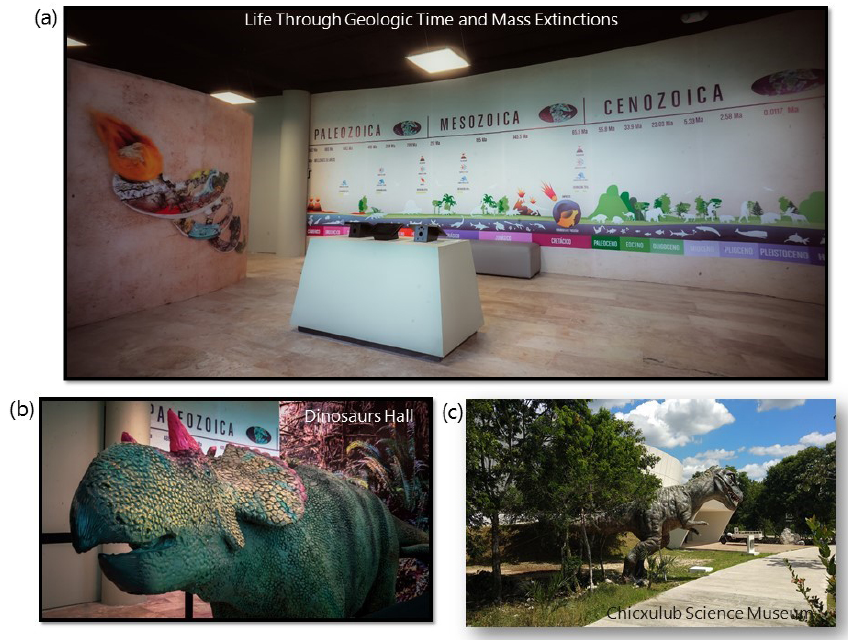
Figure 10. Chicxulub science museum and exhibits on life evolution and mass extinctions. Exhibits on dinosaurs and other flying and marine reptiles are arranged inside and in the museum